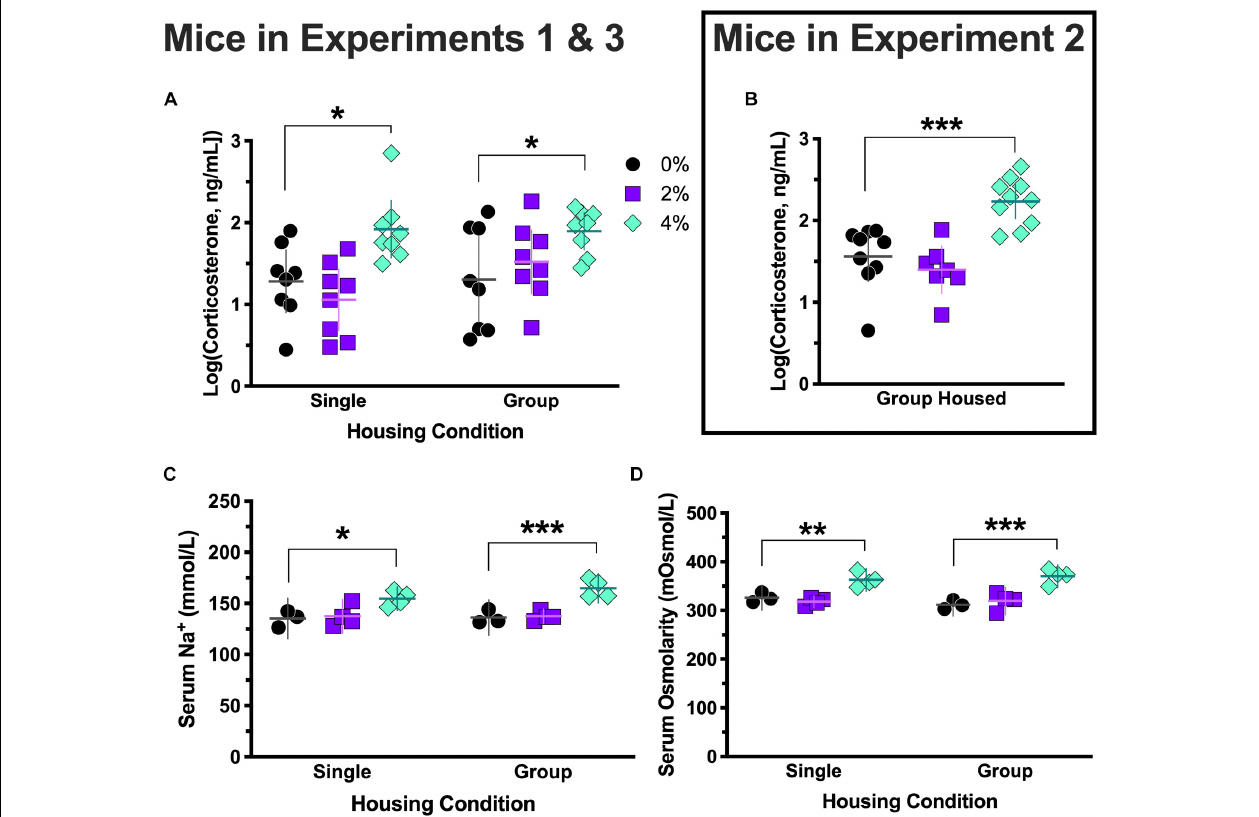
FIGURE 4 | Log-transformed serum corticosterone levels, serum sodium levels, and serum osmolarity. Corticosterone levels in Experiment 3 (group housed) mice consuming 0 and 2% salt, and in Experiment 1 (singly housed) mice consuming 4% salt, were non-normally distributed, so all corticosterone levels were log-transformed to generate normally distributed data for ANOVA analyses. Log-transformed corticosterone levels consistently revealed elevated corticosterone in mice consuming 4% salt in Experiment 3 [group housed, ∗ p = 0.026, (A) right side], Experiment 1 [single housed, ∗ p = 0.016, (A) left side], and Experiment 2 [group housed, ∗∗∗ p = 0.0004 ( B )]. Serum sodium (Na + ) levels were significantly higher in mice consuming 4% salt in both Experiment 3 [group housed, ∗∗∗ p < 0.0005, (C) right side] and Experiment 1 [singly housed, ∗ p = 0.011, (C) left side]. Serum osmolarity was also significantly elevated in both group [Experiment 3; ∗∗∗ p < 0.0001, (D) right side] and single [Experiment 1; ∗∗ p = 0.004, (D) left side] housed mice consuming 4% salt relative to control mice, as indicated by Dunnett’s post hoc testing. Individual data points are shown, with means indicated by horizontal lines, and 95% CI indicated with vertical